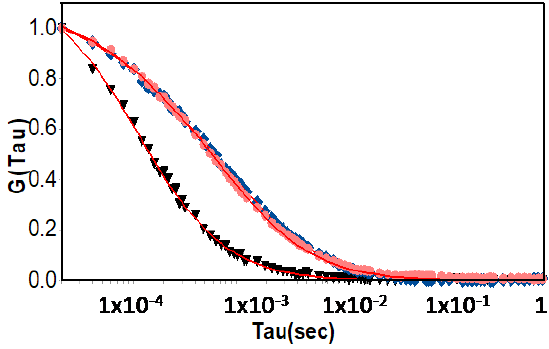
Figure 5. Auto-correlation curves obtained for DNA-ROX (black inverted triangles) and for the mixtures of 1:1 (blue diamonds) and 2:1 (red circles) of SRP:DNA-ROX, using fluorescence correlation spectroscopy.